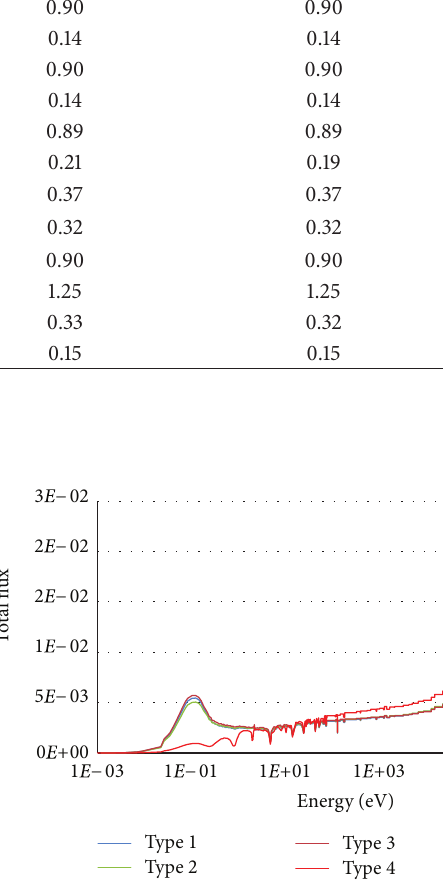
Figure 13: The neutron flux spectra of GEN-III LWR fuel assembly.